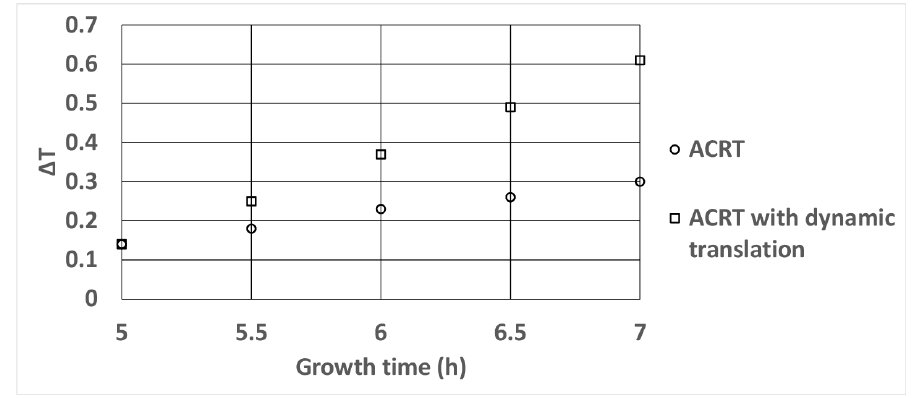
Figure 4. Difference between temperature at the wall and at the centerline along the growth interface.